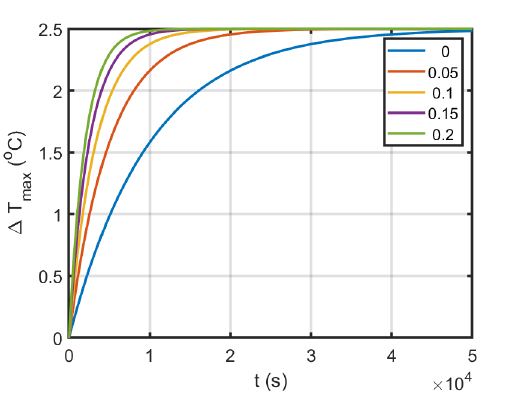
Figure 27. Effect of nanoparticle concentration on maximum